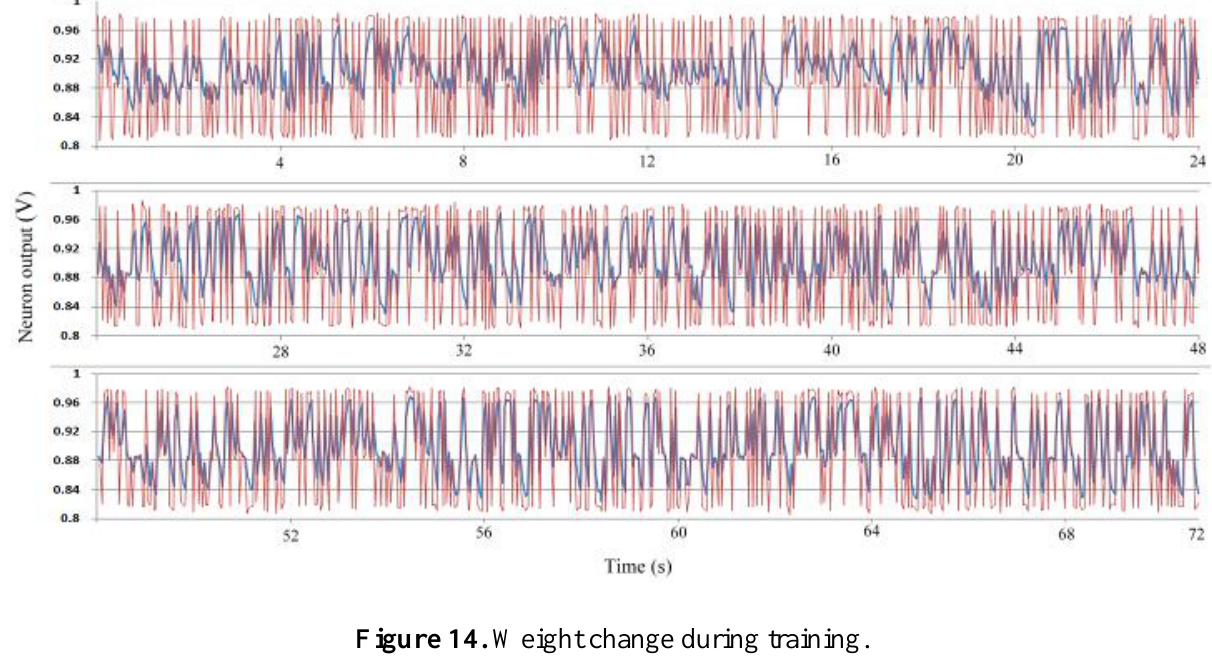
Figure 13. Neuron output during training.